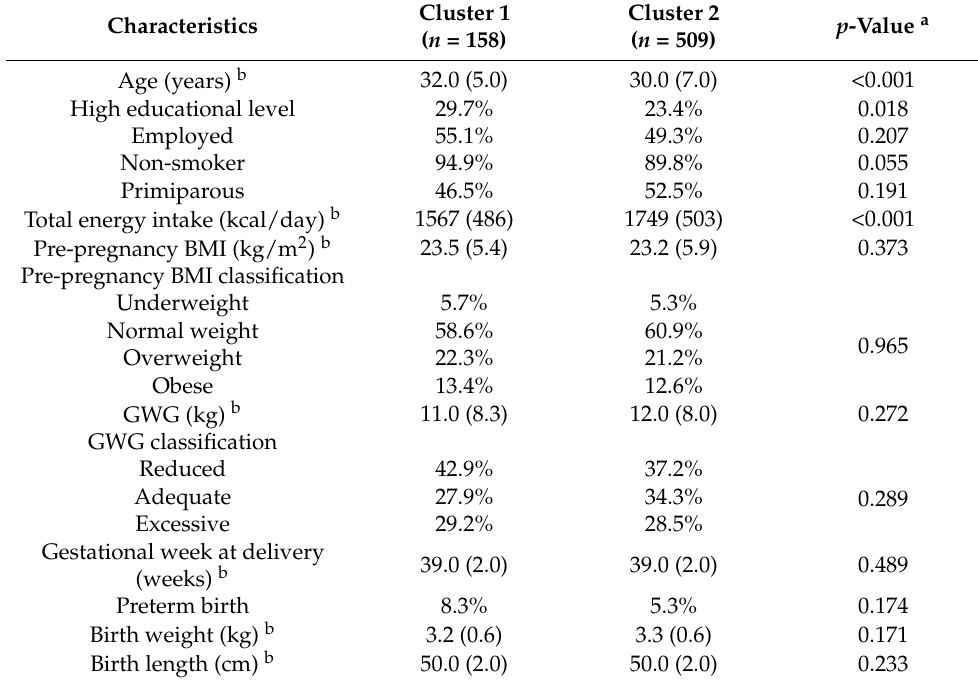
Table 1. Characteristics of the study population by clusters reflecting dietary